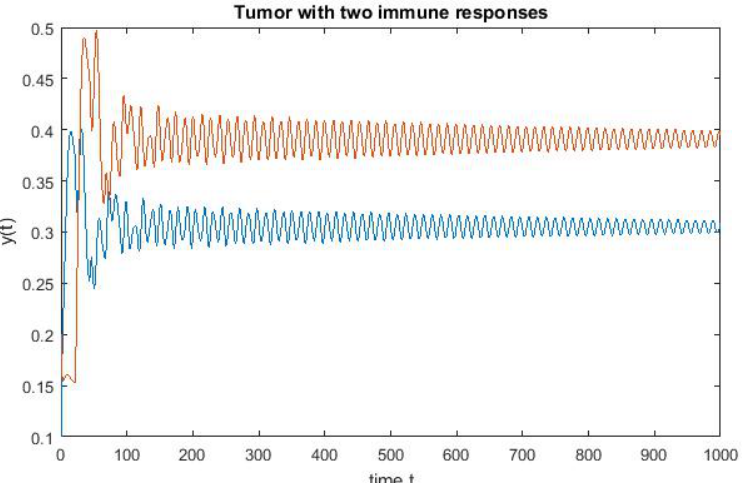
Figure 14. Simulation result of tumour populations at interphase (blue line) and mitosis (red line) when τ = 16.7676 for the system (1) at E 1 = ( 0.1,0.39,2.62,11.41 ) .